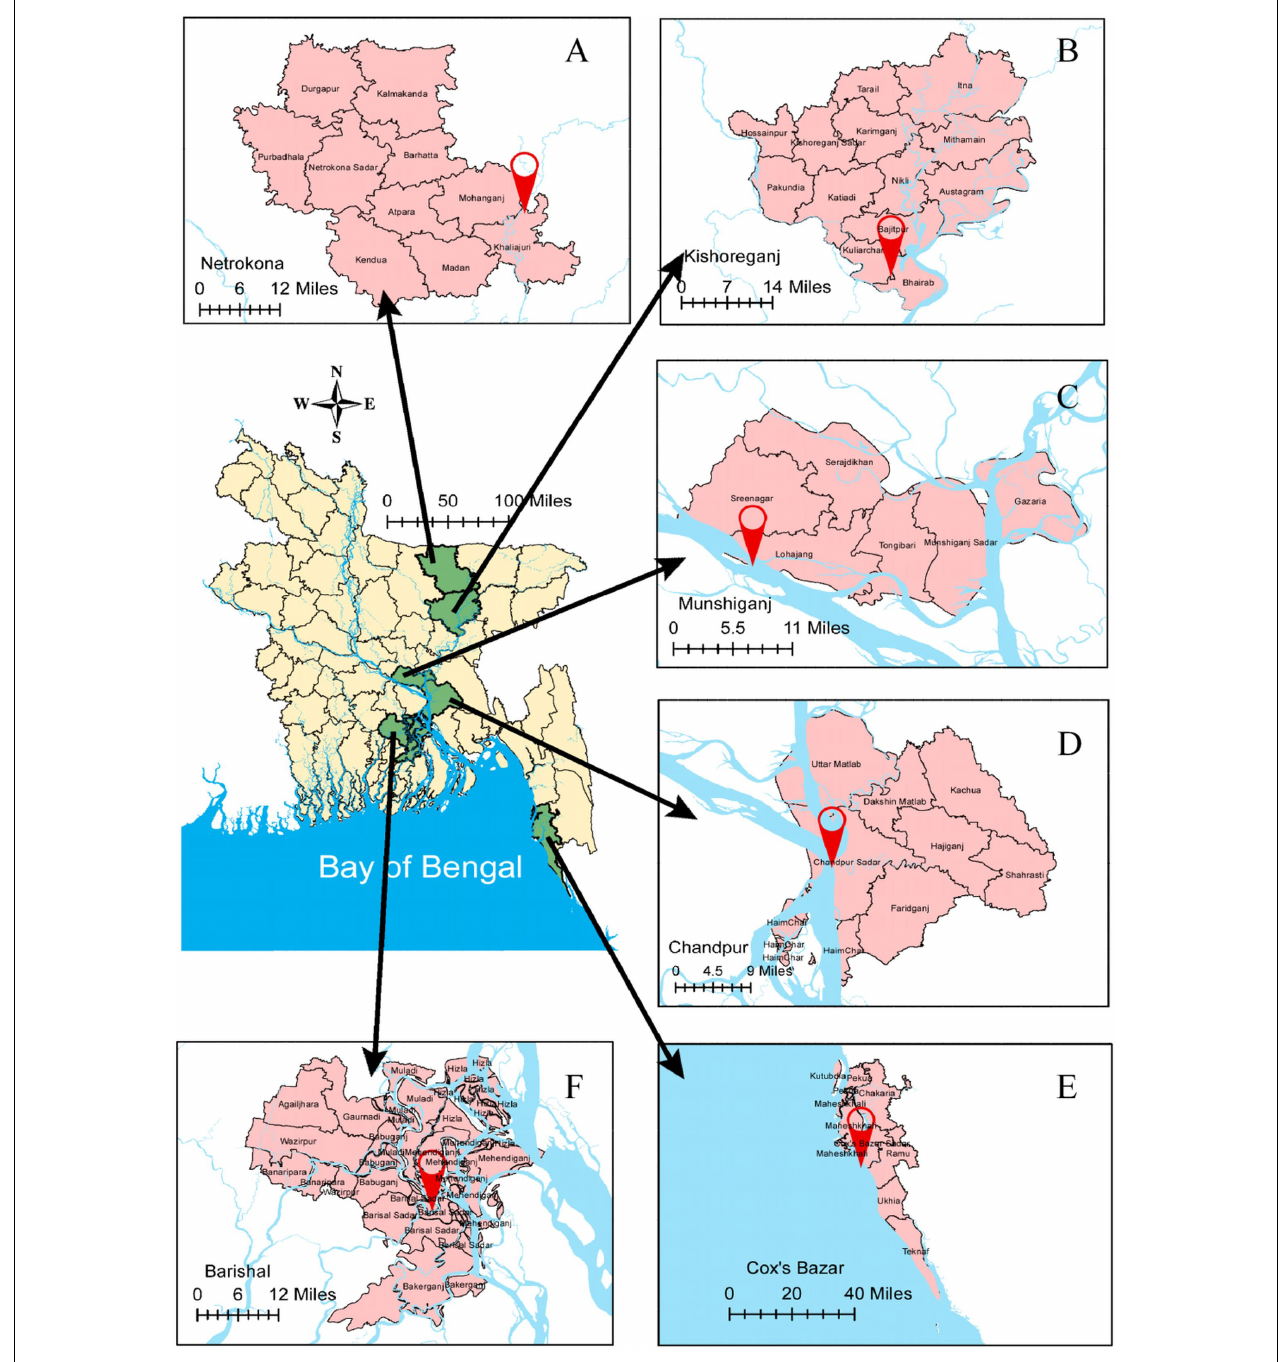
FIGURE 1 | Graphical picture of six sampling locations of Hilsa for the experiment. (A) the Gaglajur Haor, Mohanganj, and Netrokona; (B) the Kali River, Kishoreganj; (C) the Padma River, Mawa, and Munshiganj; (D) the Meghna River Estuary, Chandpur; (E) the Bay of Bengal, Cox’s Bazar; and (F) the Tetulia River,